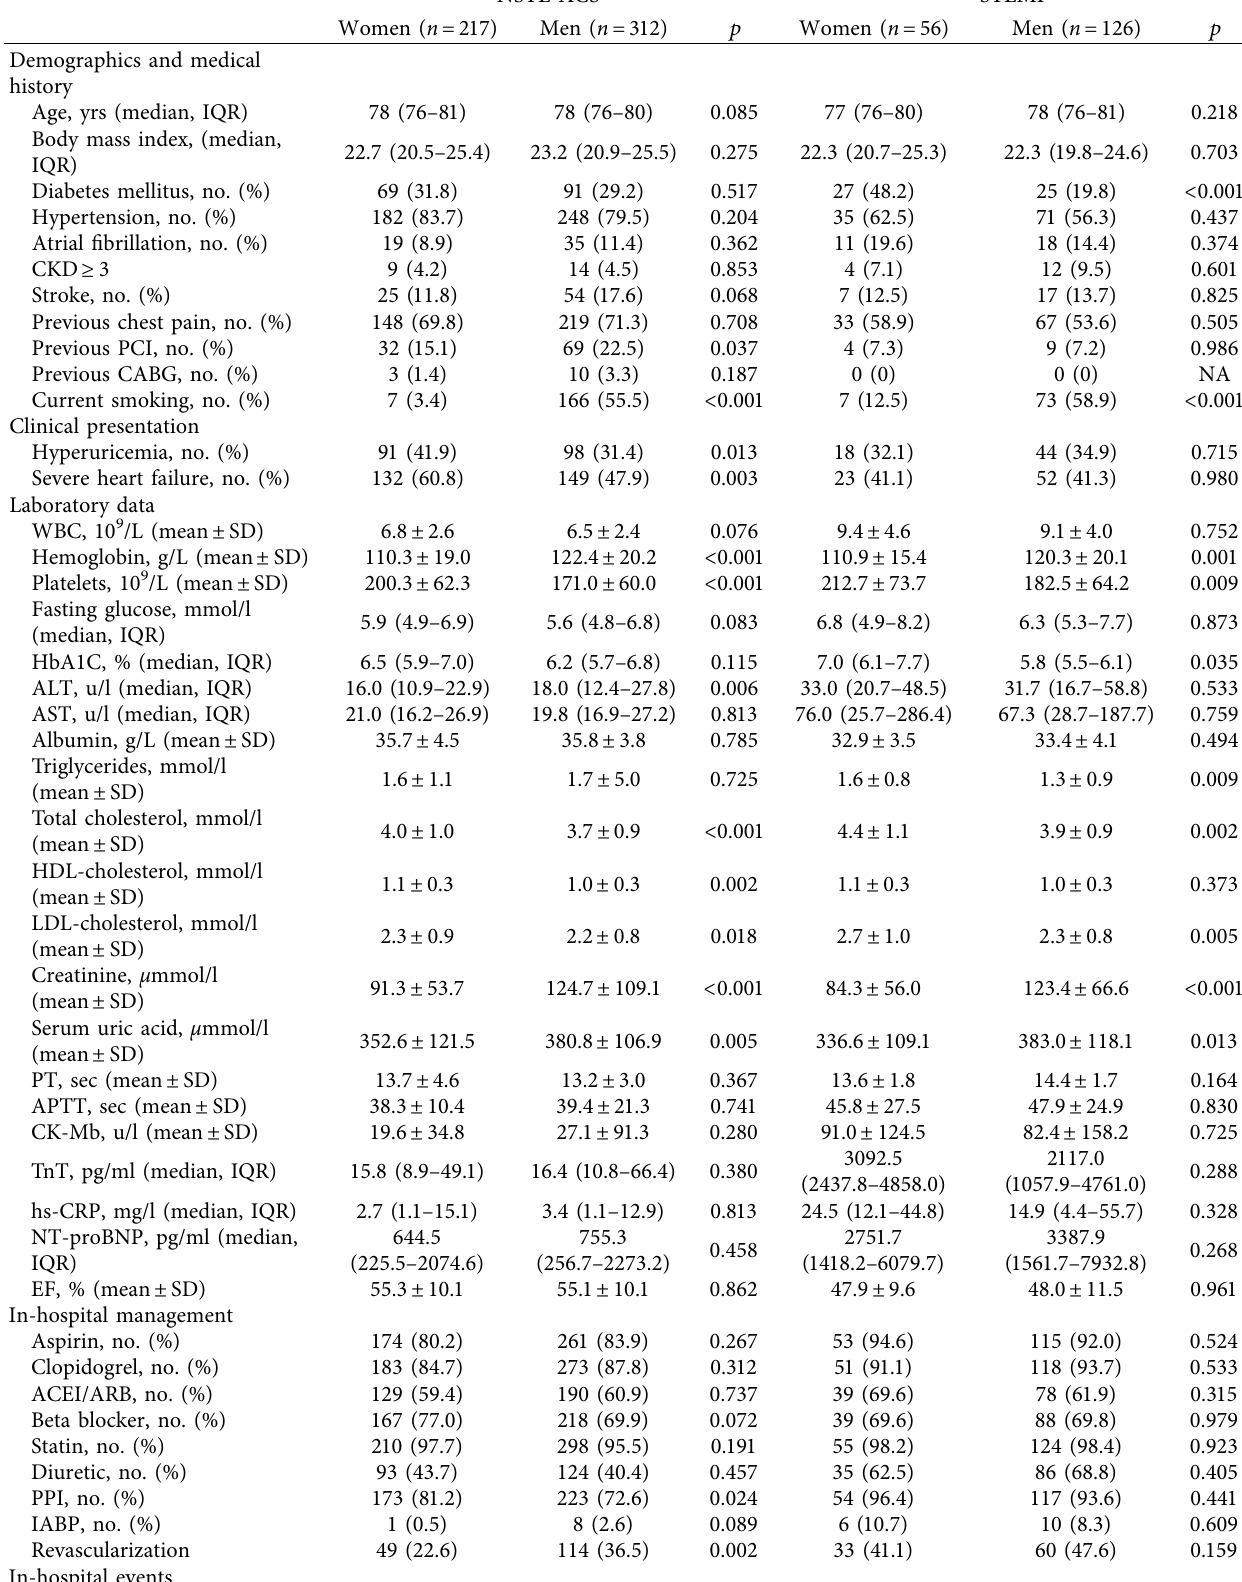
Table 2: Differences between women and men according to ACS